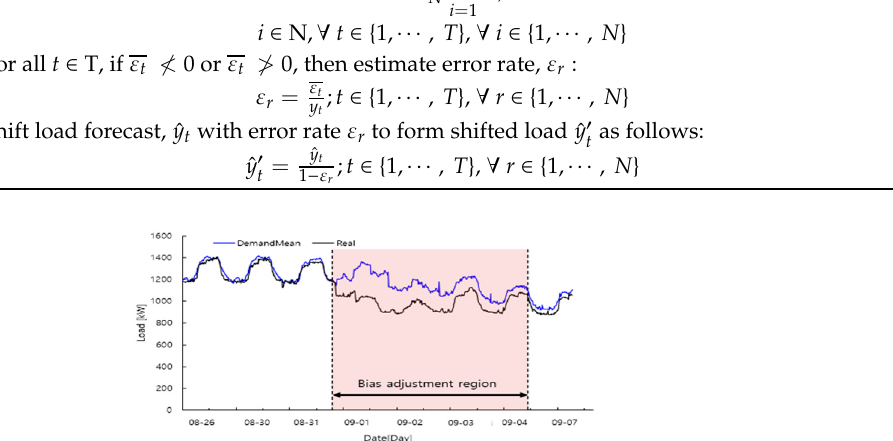
Algorithm 3: Permanent Bias Error Correction Model